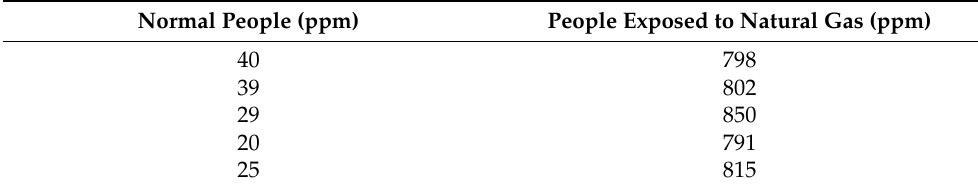
Table 7. Natural gas levels for the experimental